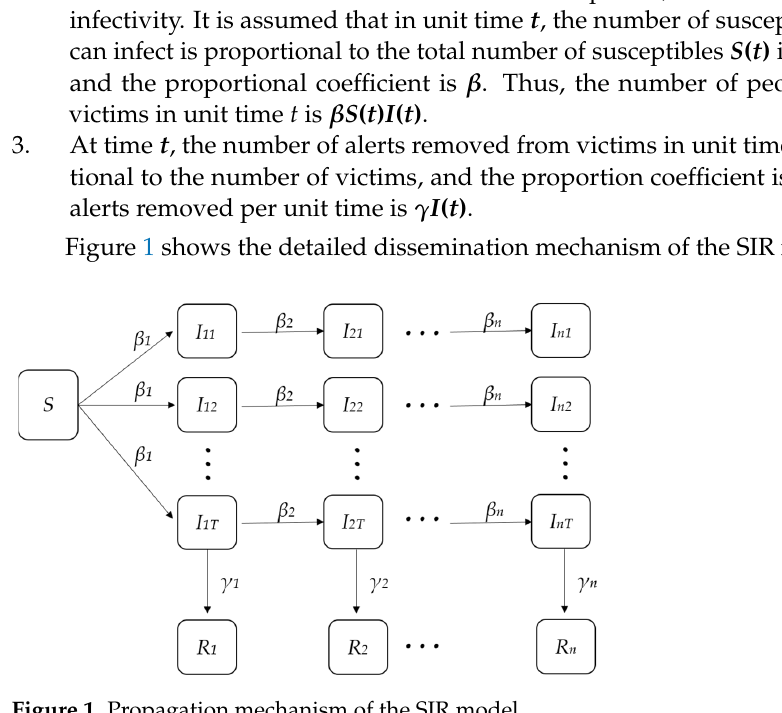
Figure 1. Propagation mechanism of the SIR model.